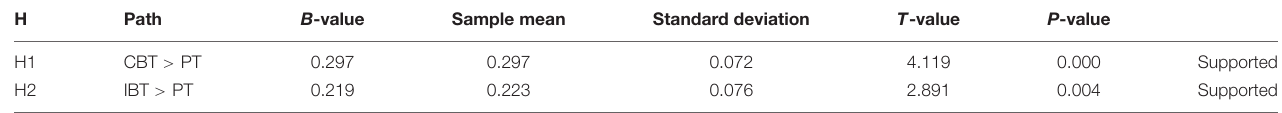
TABLE 4 | Hypothesis testing.